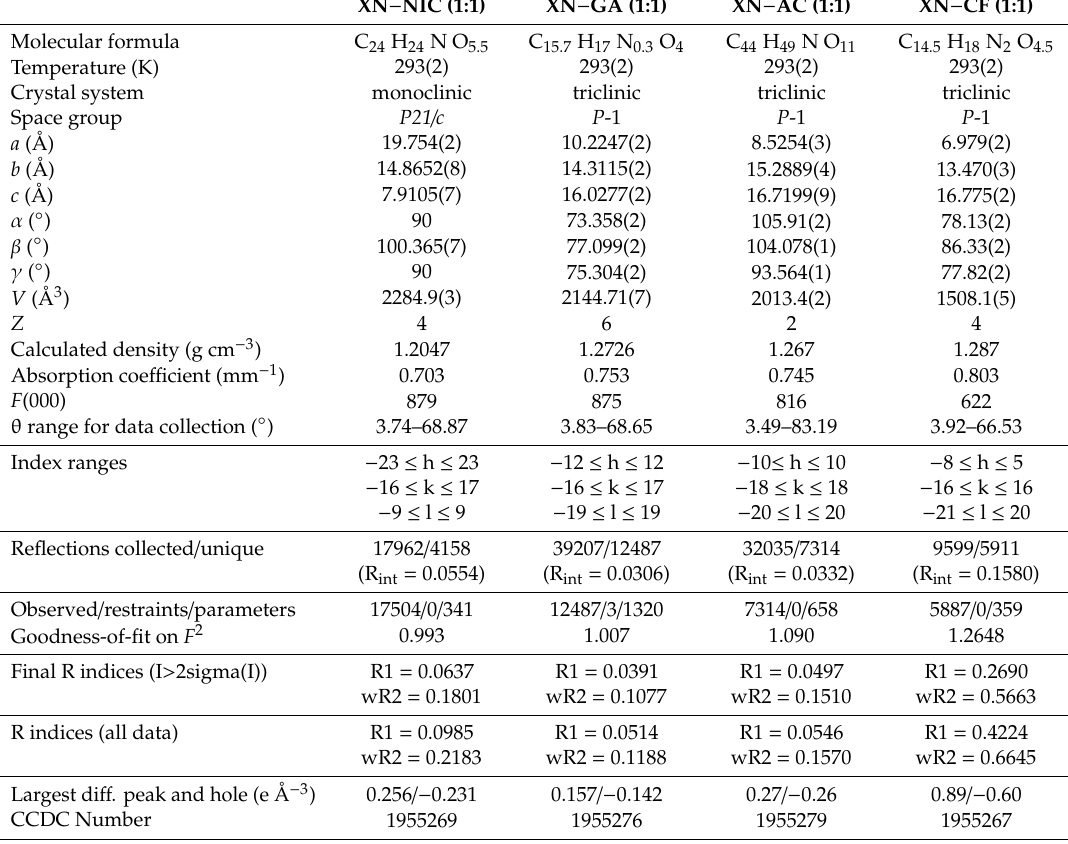
Table 1. Crystallographic parameters and refinement details for the target